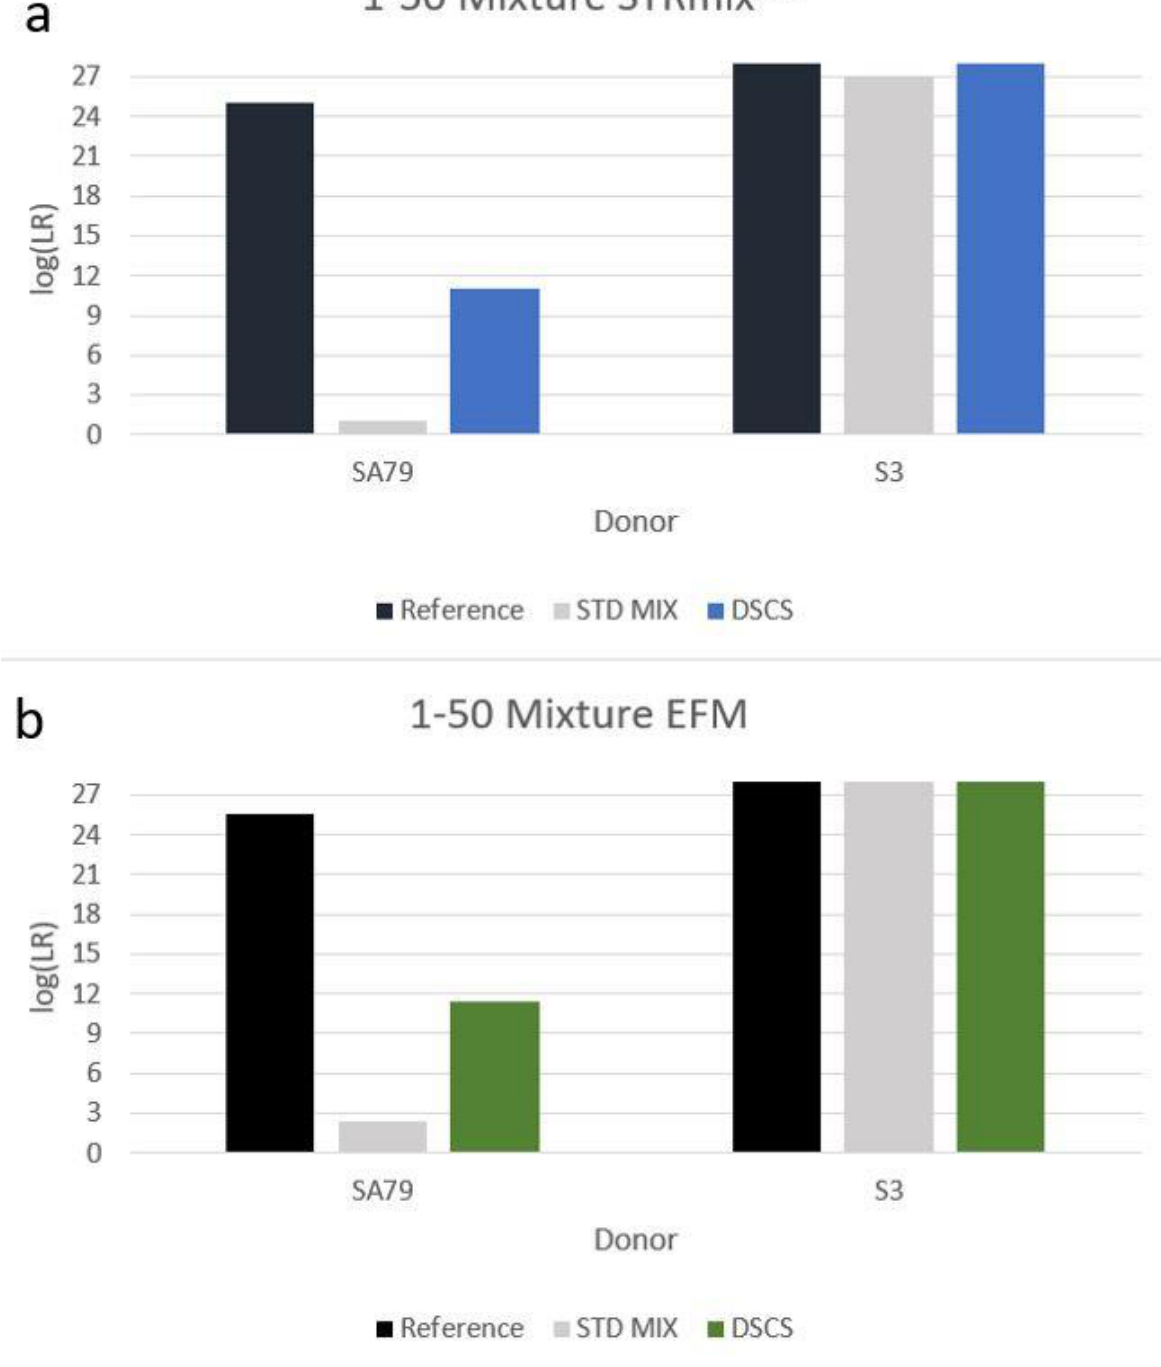
Figure 3. Increased minor donor contributor log(LR) recovery in a 1:50 2-person mixture by DSCS compared to standard PG mixture analysis. STRmix TM ( a ) and EuroForMix ( b